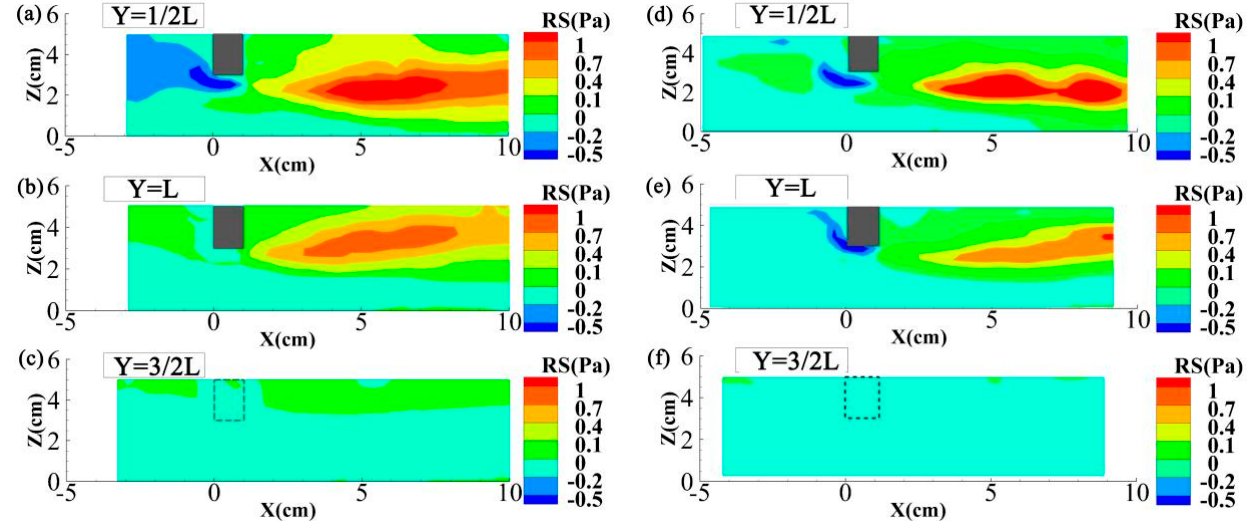
Figure 13. Distributions of the <u’w’> component of Reynold stress at longitudinal sections ( a ) Y = 1/2 L, ( b ) Y = L, ( c ) Y = 3/2 L in Case 5 (on the left) and at longitudinal sections ( d ) Y = 1/2 L, ( e ) Y = L, ( f ) Y = 3/2 L in Case 6 (on the right). The grey areas in subfigures ( a ), ( b ), ( d ) and ( e ) demonstrate the floating dike, and the dotted lines in subfigures ( c ) and ( f ) indicate the location of floating dike in the coordinate system.